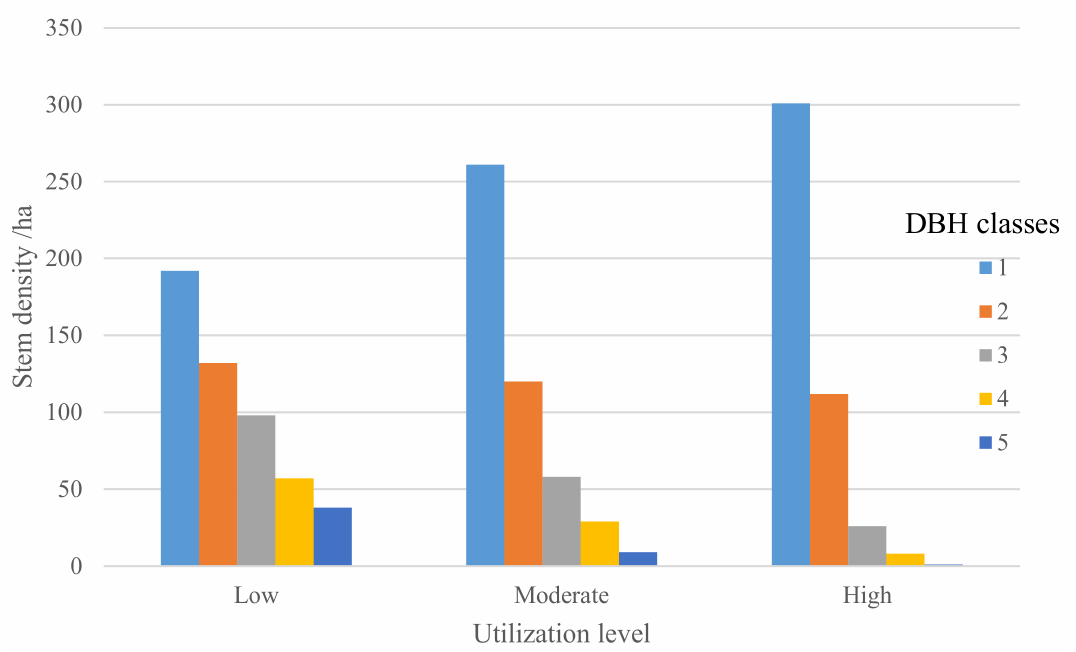
Figure 4. The structure of the stand based on DBH classes over different land utilization regimes: (1) DBH < 10 cm; (2) DBH 11–20 cm; (3) DBH 21–30 cm; (4) DBH 31–40 cm; (5) DBH ≥ 40 cm.